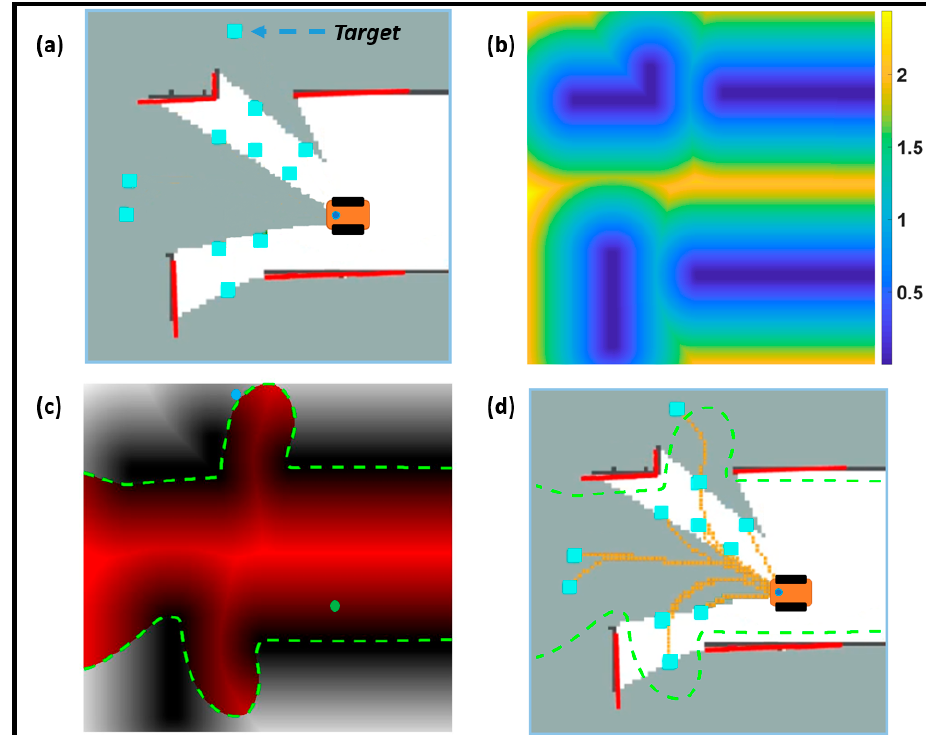
Figure 4. The schematic diagram shows the multiple path generation using fast marching. ( a ) The cyan-colored squares represent the frontiers generated by the Frontiers Processing module. ( b ) The velocity field of the environment. ( c ) The wavefront propagates from the robot’s location (green dot) to the target point (blue dot). The red area represents the range of the wave, and the green dashed line represents the wavefront. ( d ) The yellow line represents the generated multiple paths from the robot position to the unexplored frontiers.